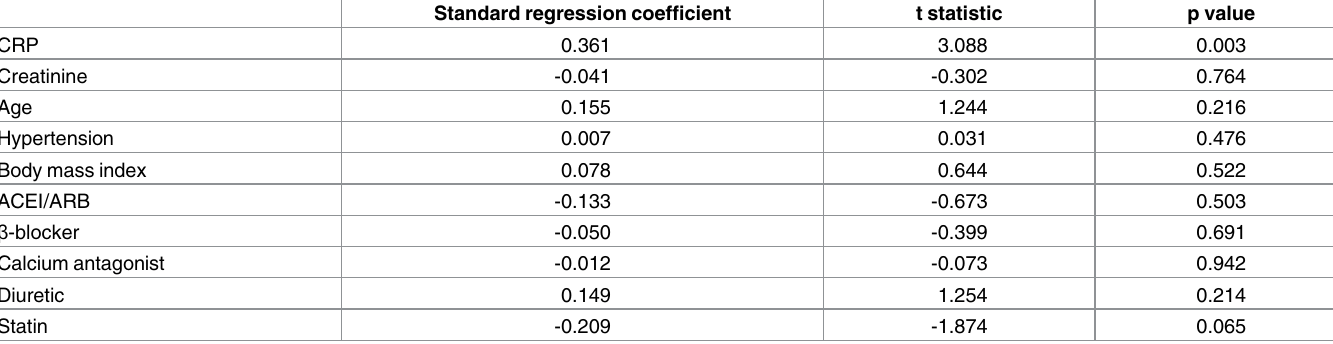
Table 2. Multiple regression analysis of the BNP levels and potential associated factors in patients with